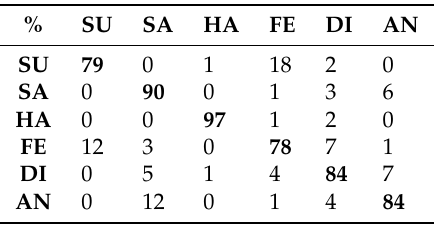
Table 6. Confusion matrix: 89 features.